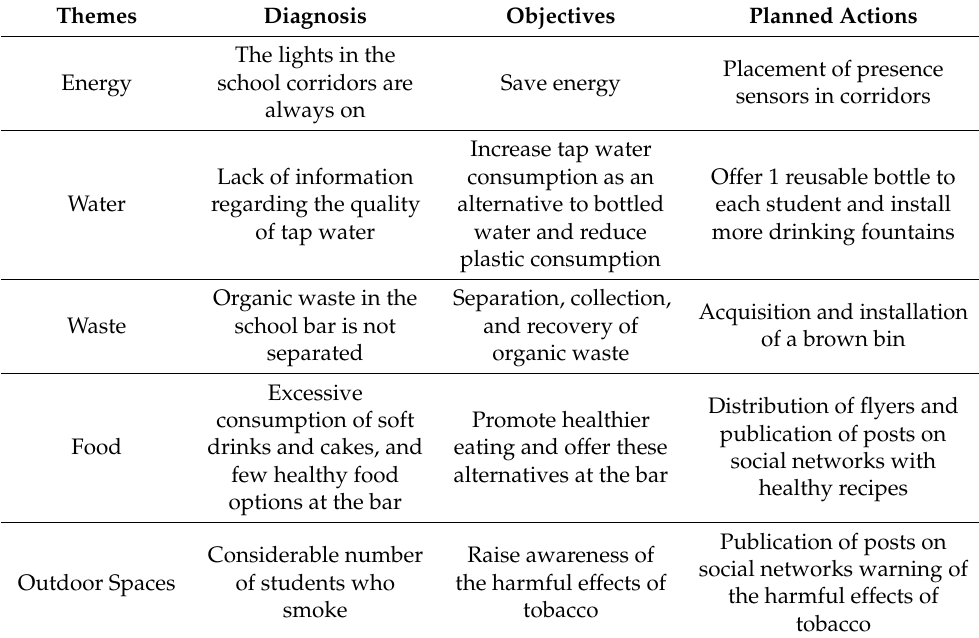
Table 4. Action Plan in the Eco-Schools Programme.